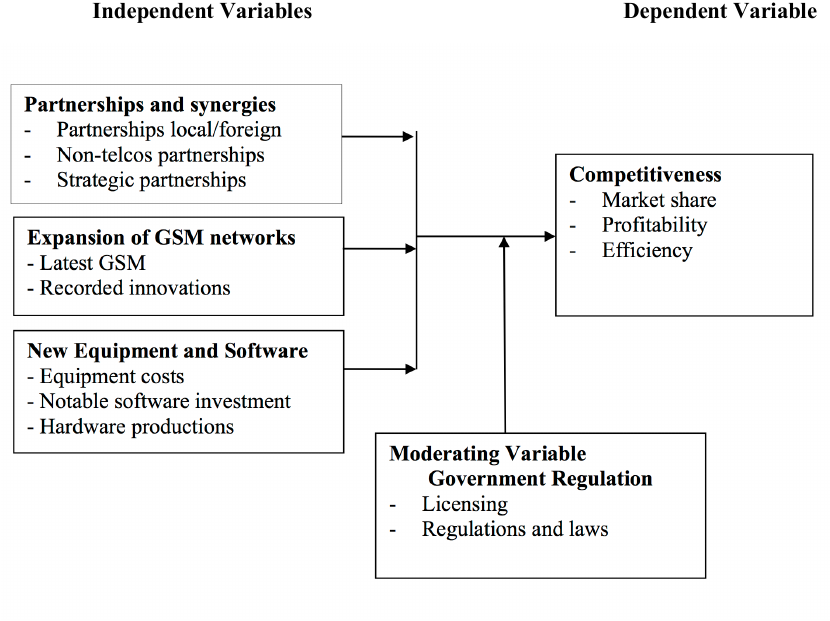
Figure 1: Conceptual